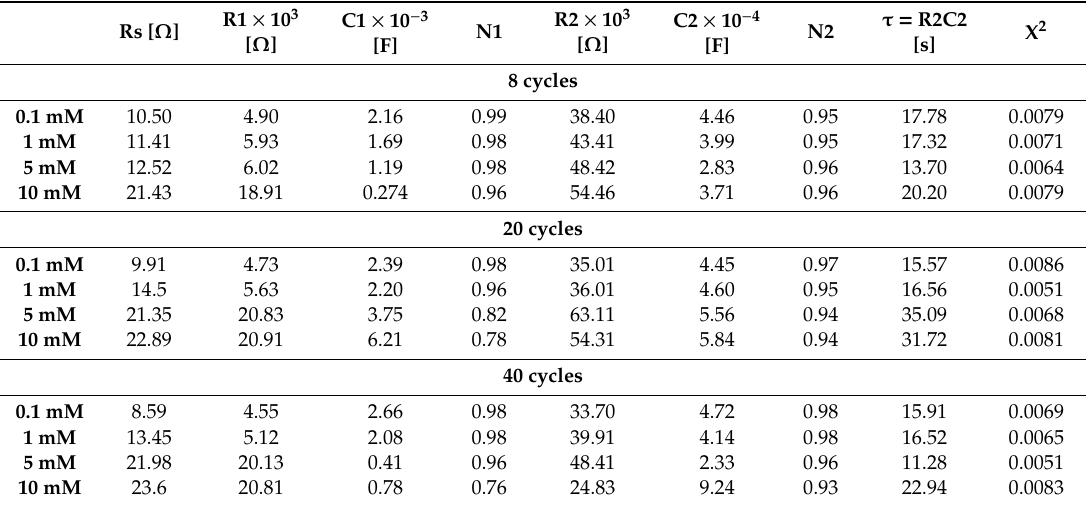
Table 4. Values of circuit equivalent elements for TNTs before and after gold nanoparticles deposition 8, 20, and 40